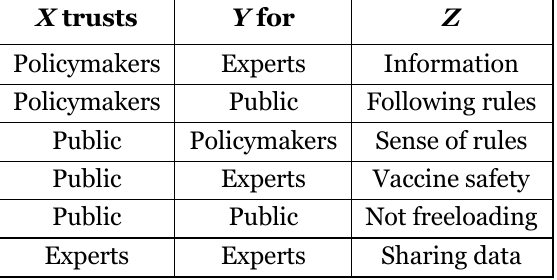
Table 1. Trust relations relevant to the Covid-19